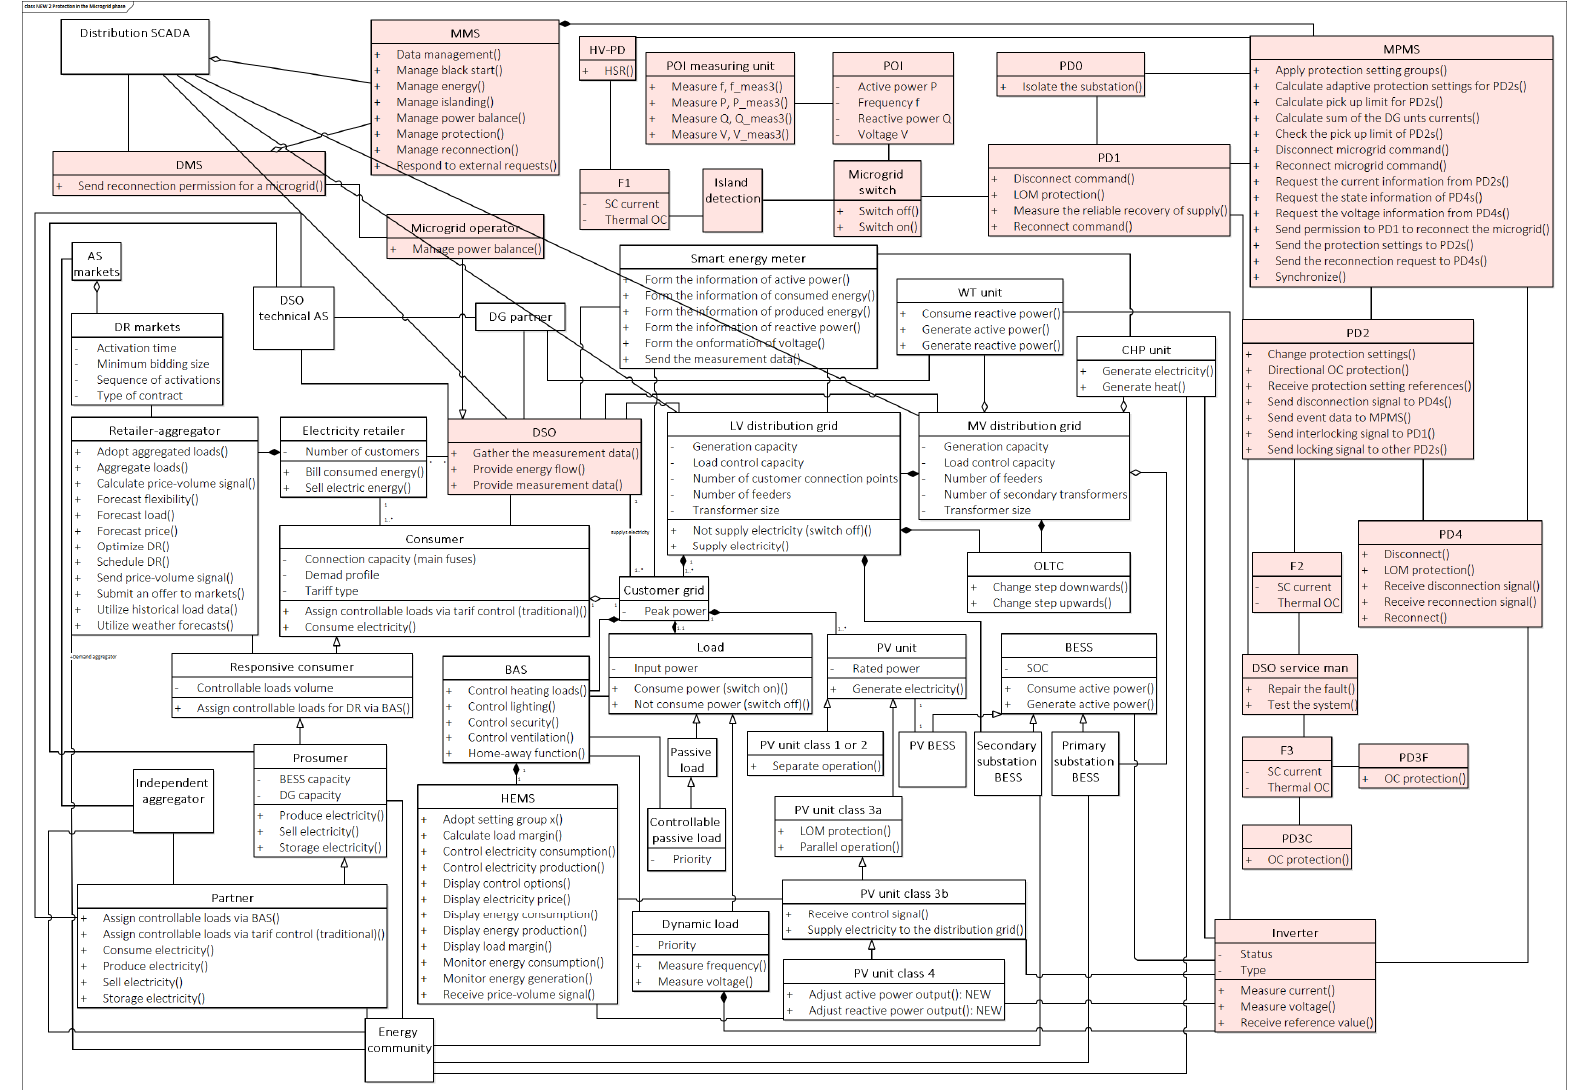
Figure A3. Class diagram of the overcurrent protection of the microgrid phase.